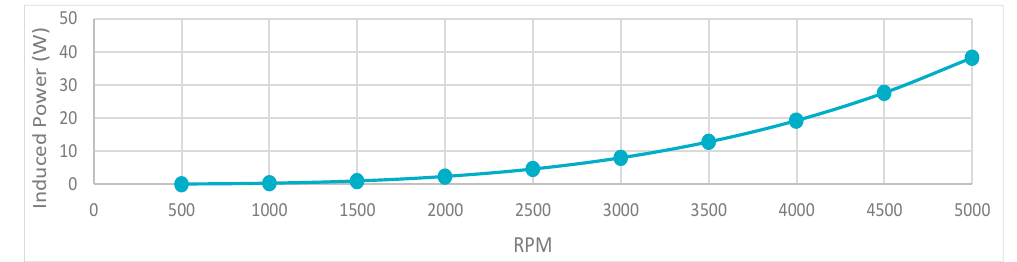
Figure 11. T-Motor 16 inch × 5.4 inch rotor theoretical profile drag at zero lift.